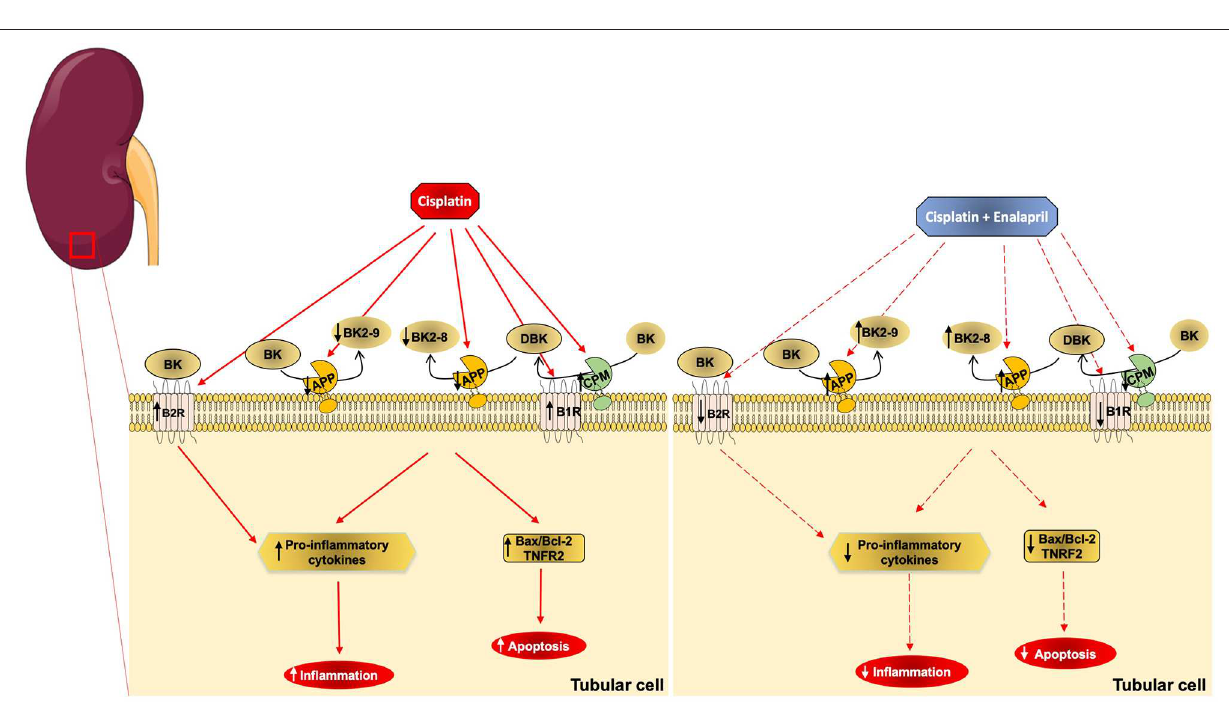
FIGURE 8 | Schematic representation of cisplatin and enalapril effects on aminopeptidase P and B1R signaling in renal tubular cells. The scheme shows that cisplatin (CIS) decreases APP activity, which leads to decreased kinin degradation that increases des-arg9-BK (DBK) availability and leads to increased inflammation and apoptosis. It also shows that B1 receptor and CPM upregulation by cisplatin toxicity increases B1 receptor signaling. Additionally, it shows that enalapril + CIS increases APP activity compared to CIS alone, increasing kinin degradation, which decreases des-arg9-BK (DBK) concentration, lowering inflammation and apoptosis. On the other hand, enalapril also decreases B1 receptor and CPM expression reducing B1 receptor